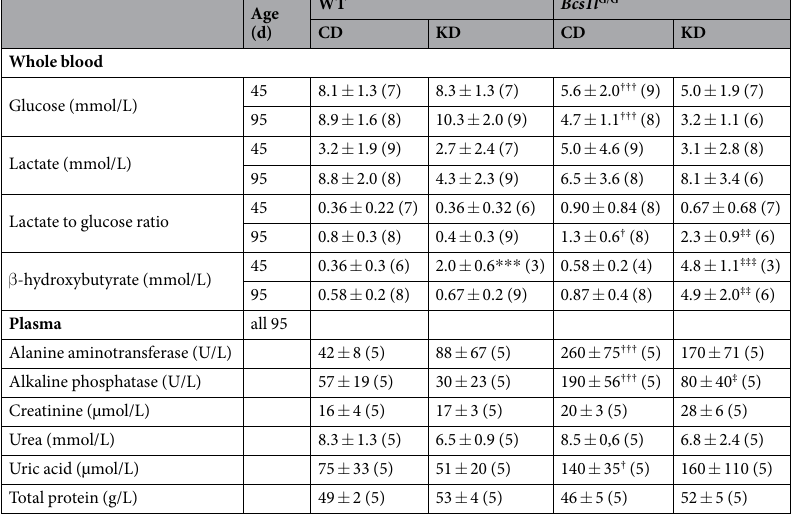
mouse genome 7 . The homozygous mice display growth failure, low blood glucose, high blood lactate and progres- sive hepatopathy from the fourth week of age, recapitulating many of the main findings in the patients. Carbohydrate-restricted high-fat ketogenic diets stimulate mitochondrial β -oxidation and ketone body pro- duction in the liver 8, 9 . Ketone bodies can be utilized as an alternative energy source by the brain, heart and skeletal muscle. KDs are an established therapy in drug-resistant epilepsies and have been shown to increase the expression of genes related to tricarboxylic acid cycle and RC function, as well as the number of mitochondria